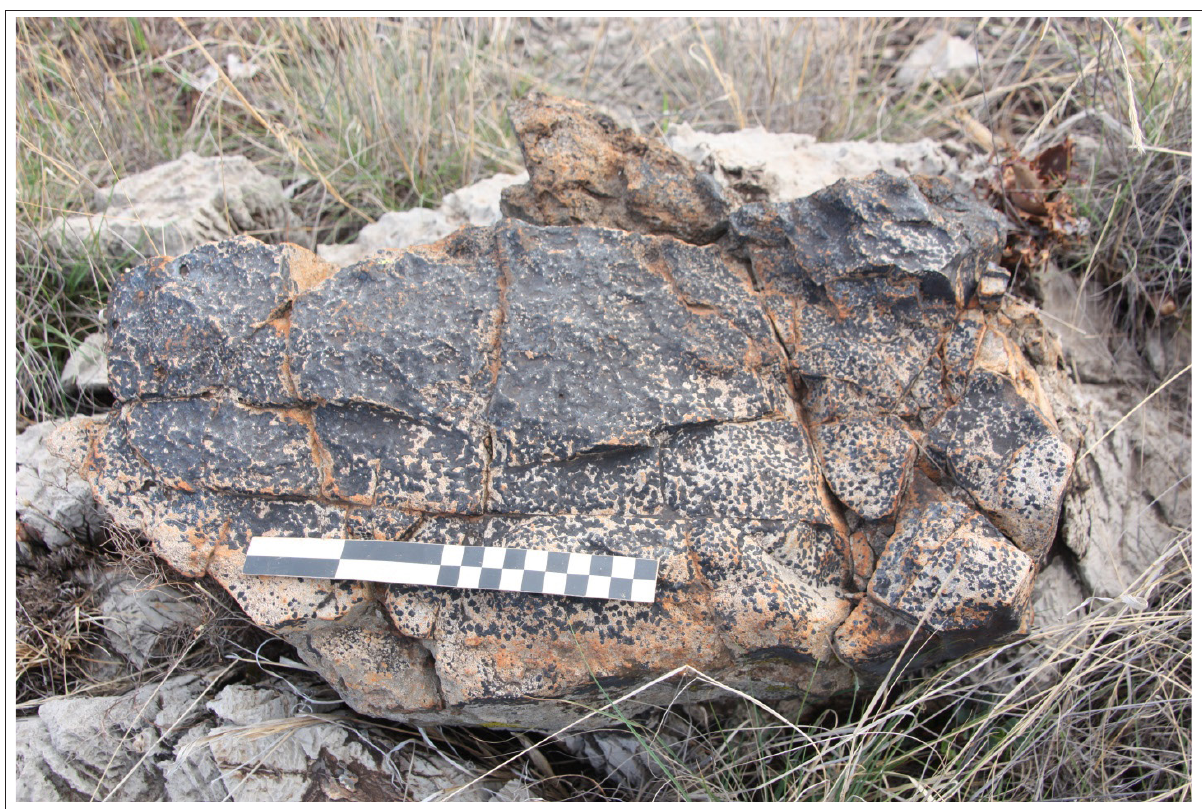
Figure 2: A chert rock at Kromdraai, showing the distribution of spots of manganese oxy-hydroxide. These spots may relate to former growth of lichen which dispersed in spots from central thalli. The size of spots of manganese oxy-hydroxide generally decreases from a central mat. The smaller spots of manganese oxy-hydroxide to the right may relate to relatively young growth of lichen (compare with lichen growth in Figure 1). Scale: centimetre squares are shown in black and white. Photograph: Benjamin